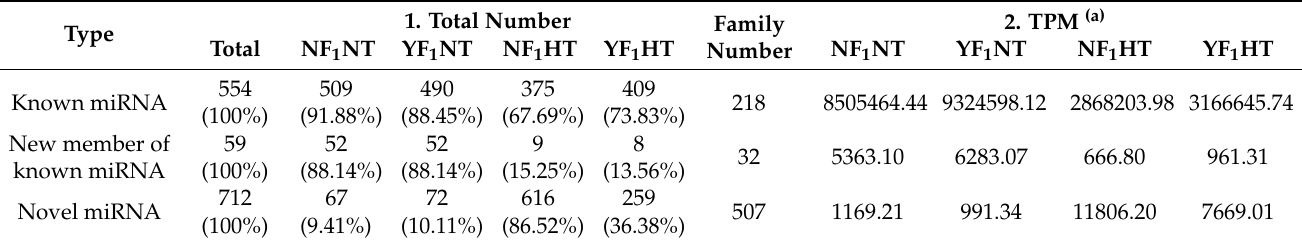
Table 1. Data statistics of miRNA in the flower bud of soybean CMS-based F 1 under HT stress. Type